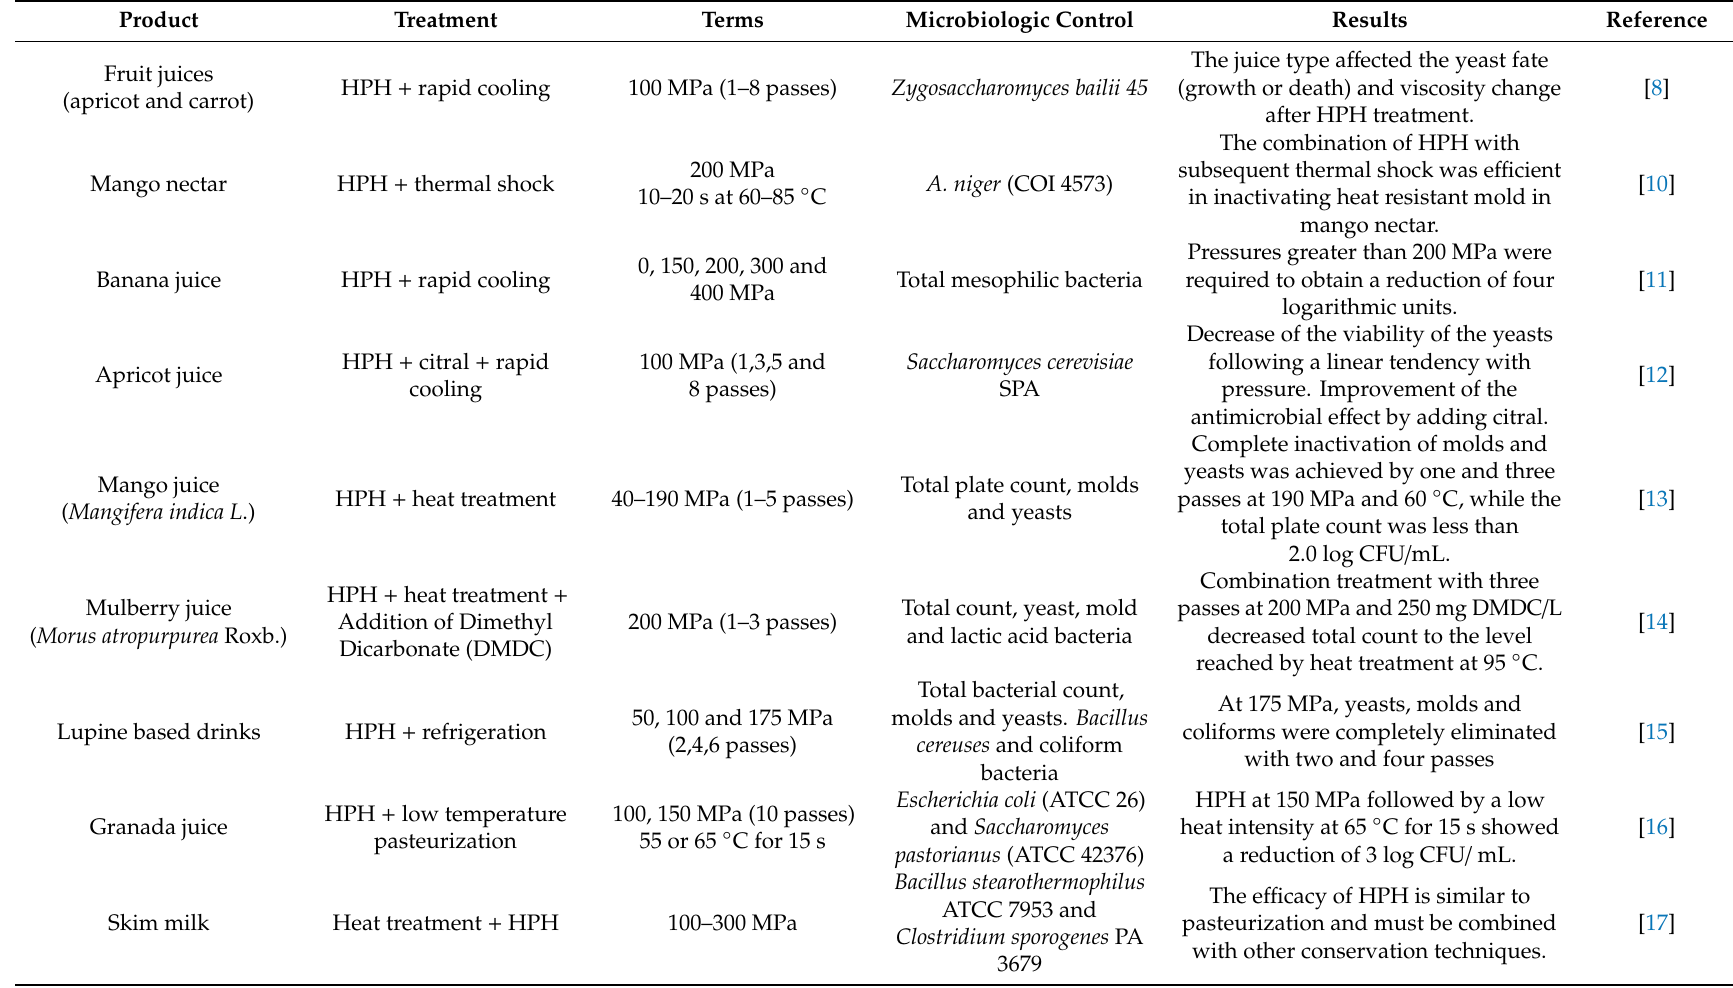
Table 1. Research works evaluating the decrease in microbial load in di ff erent food products by